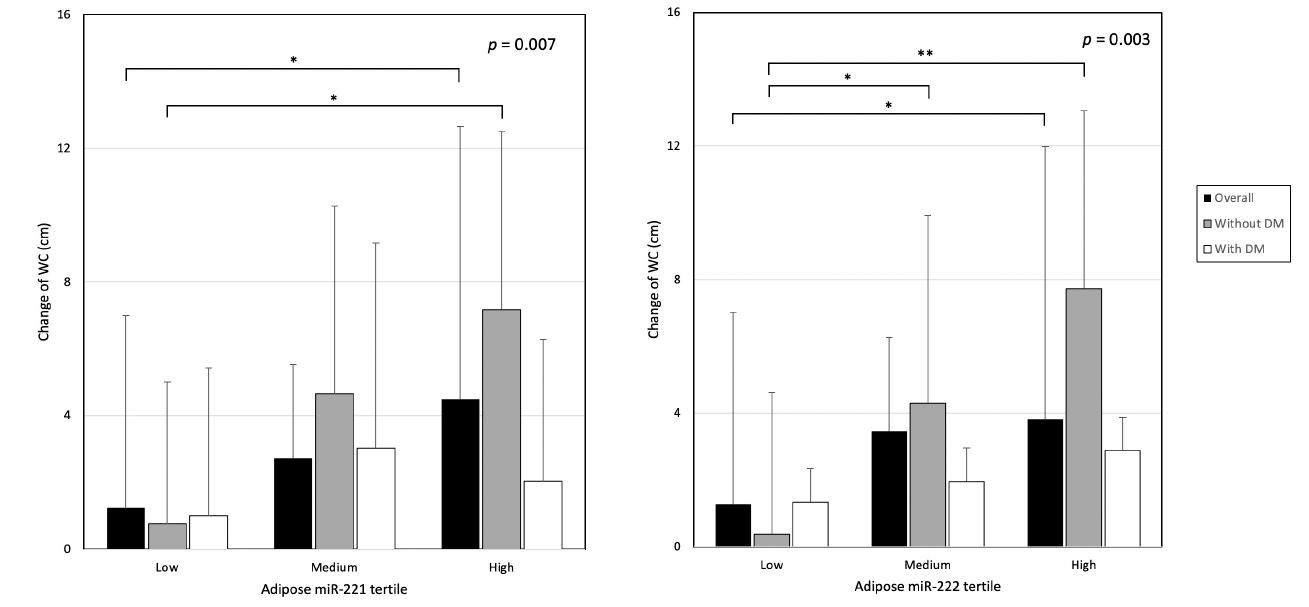
Figure 2. WC change according to adipose miR-221 and -222 tertiles. * denotes p < 0.05; ** denotes p <